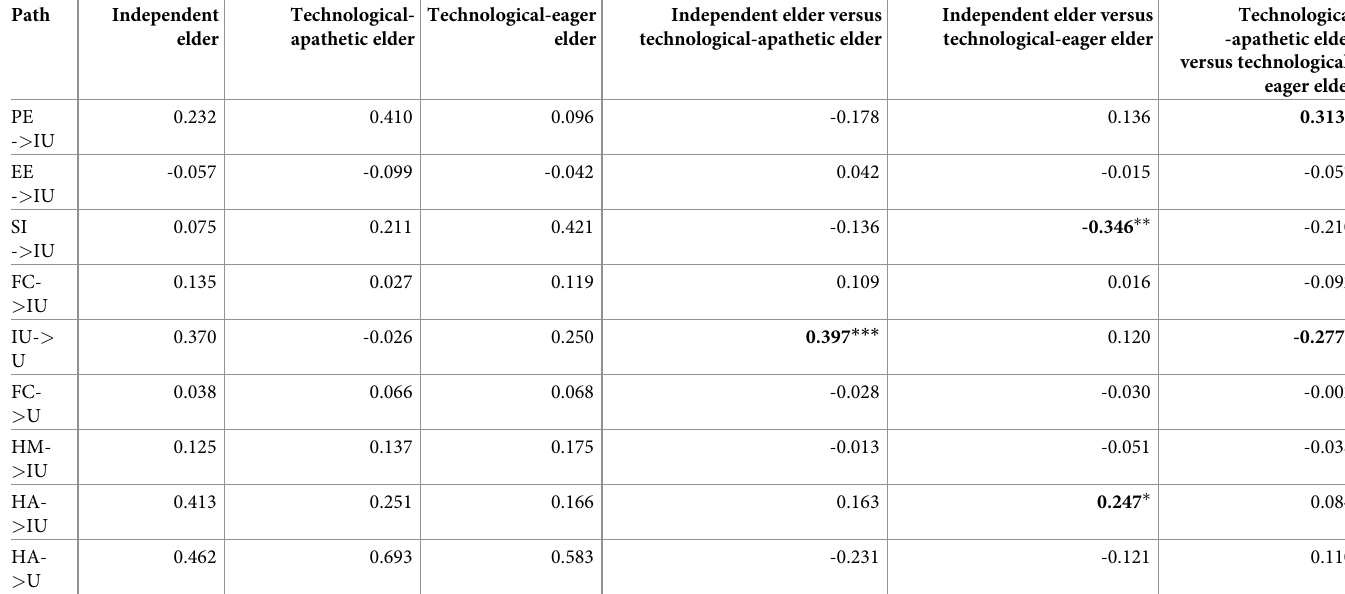
Table 11. Path coefficients’ differences and significance